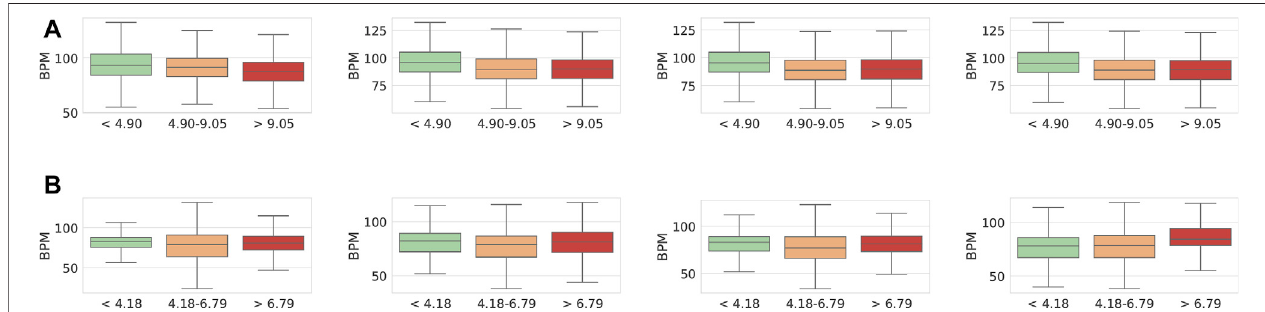
TABLE 3 | RMSE as BPM for single- and multi-domain results for BPM prediction on the REG-TSST and ULM-TSST corpora using EGEMAPS and the LSTM-based architecture.